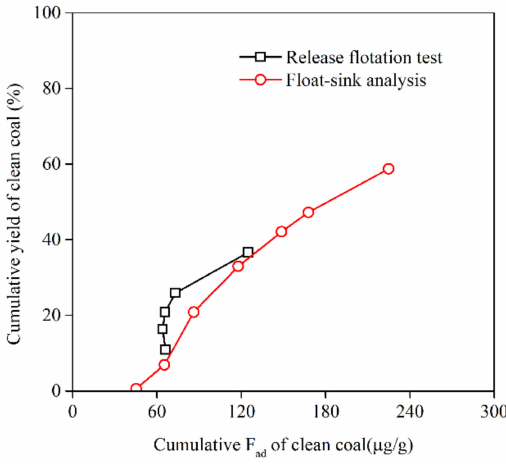
Figure 8. Comparison of upgrading curves (F ad vs. yield) of <0.5 mm coal between float–sink and release flotation